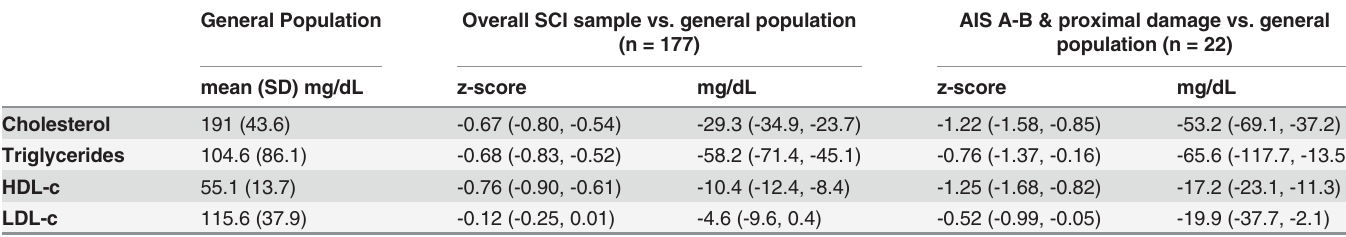
Table 5. Serum lipid values comparing SCI subjects with age- and sex-strati fi ed reference values for the general population. General